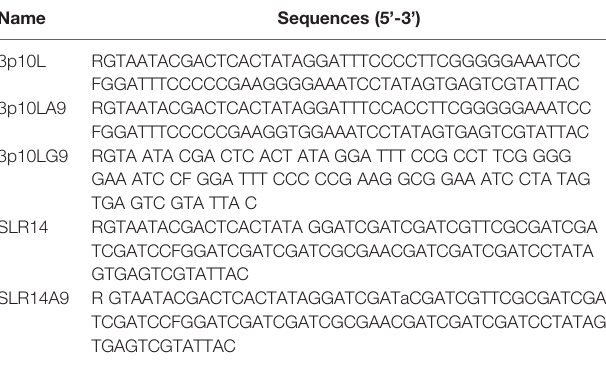
TABLE 2 | List of DNA Templates for